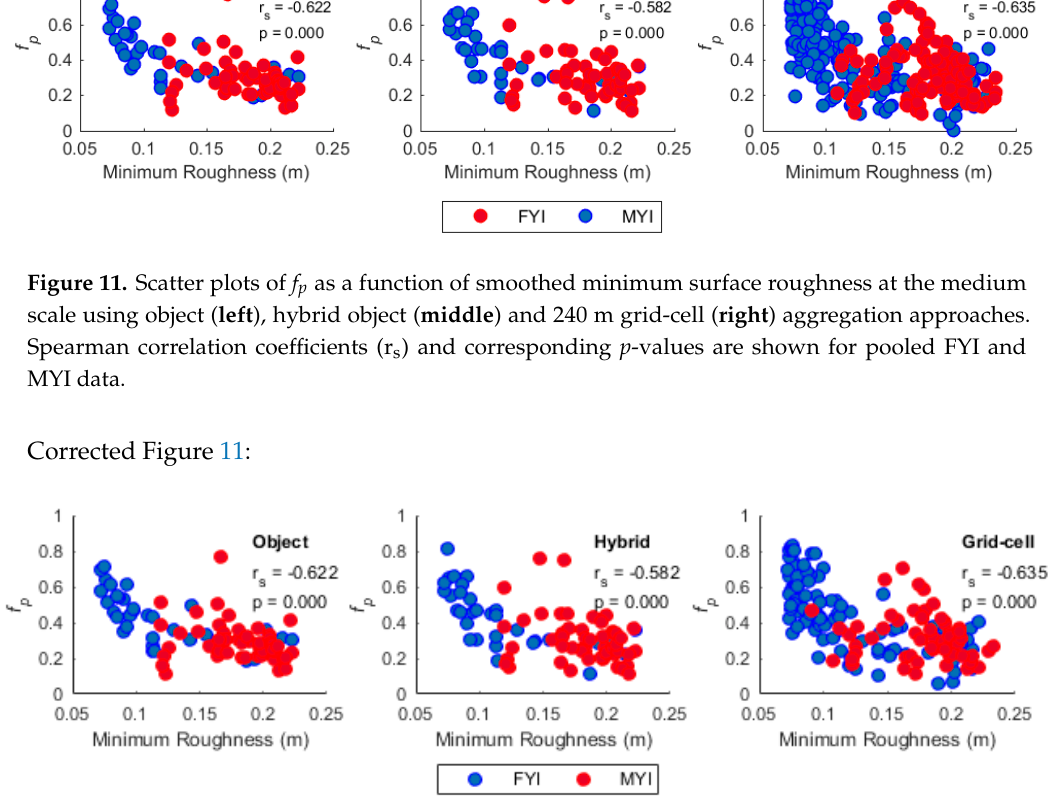
Figure 11. Scatter plots of f p as a function of smoothed minimum surface roughness at the medium scale using object ( left ), hybrid object ( middle ) and 240 m grid-cell ( right ) aggregation approaches. Spearman correlation coefficients (r s ) and corresponding p -values are shown for pooled FYI and MYI data.